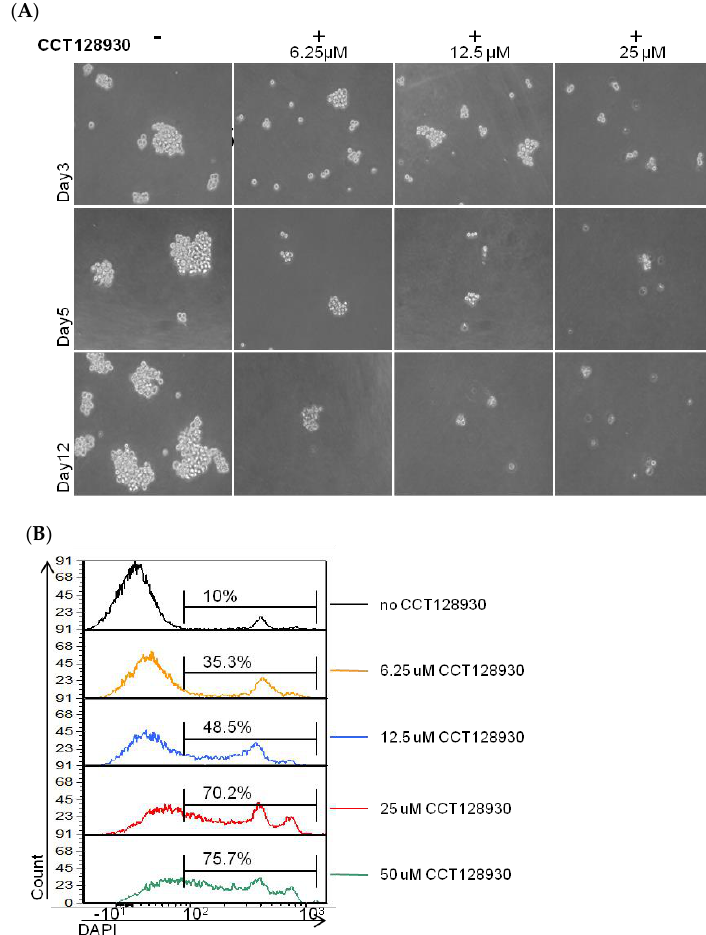
Figure 8. E ff ect of AKT2 chemical inhibition (CCT128930) on mammosphere growth. Figure 8. Effect of AKT2 chemical inhibition (CCT128930) on mammosphere growth. Sorted MDA-